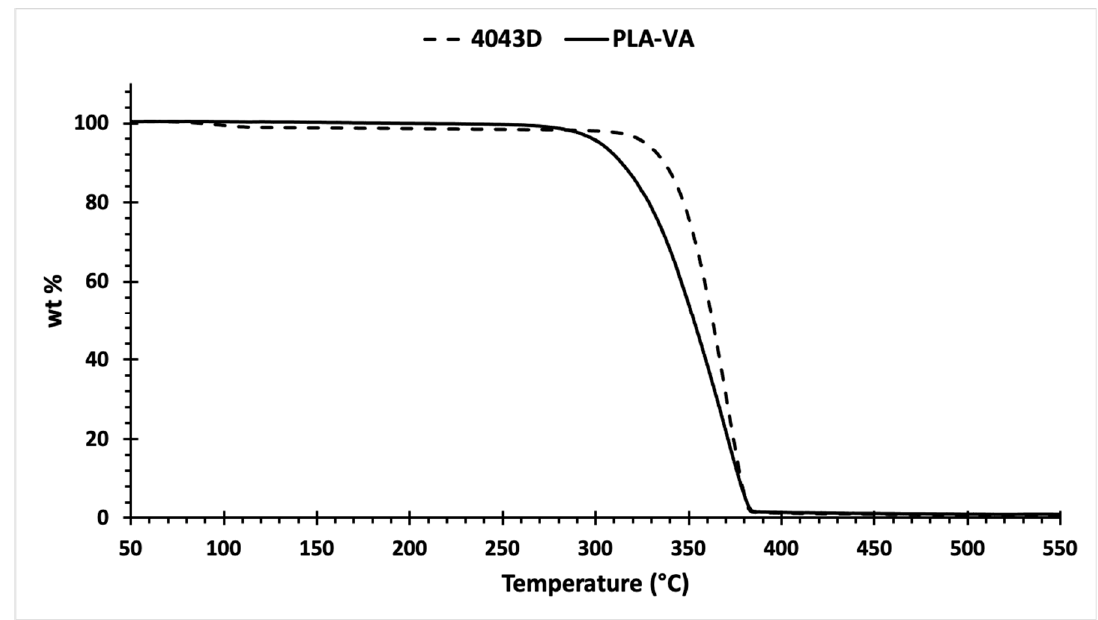
Figure 3. TGA degradation curves relative to PLA-VA and 4043D samples.